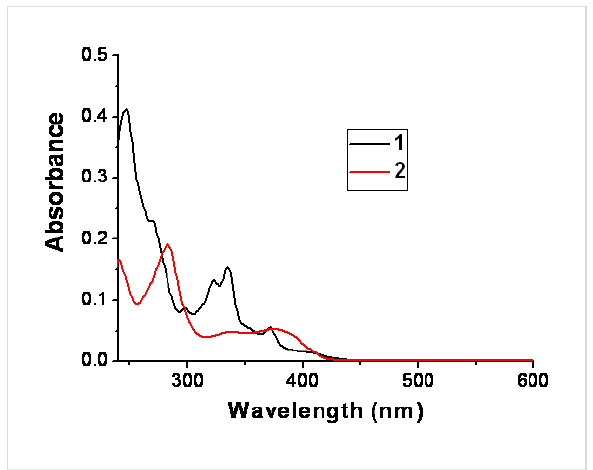
Figure 4: UV–vis spectra of 1 and 2 in chloroform ([ C ] = 1 × 10 −5 M).